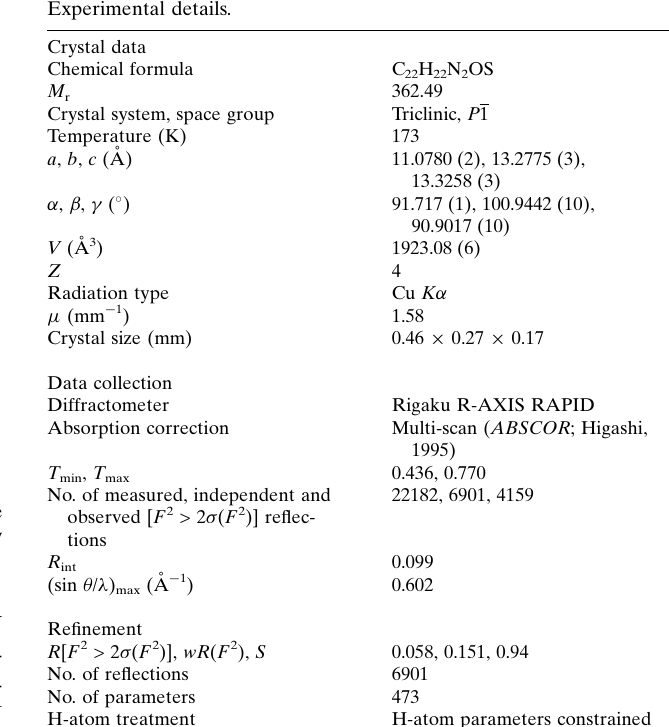
Table 2 Experimental details.